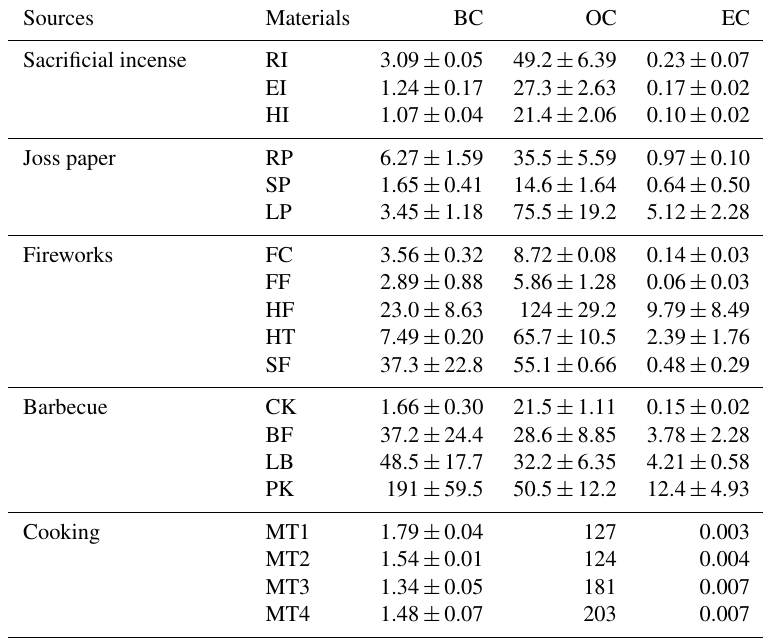
Table 1. Black carbon (BC), organic carbon (OC), and elemental carbon (EC) emission factors for the five missing sources (FMSs) (in mgkg − 1